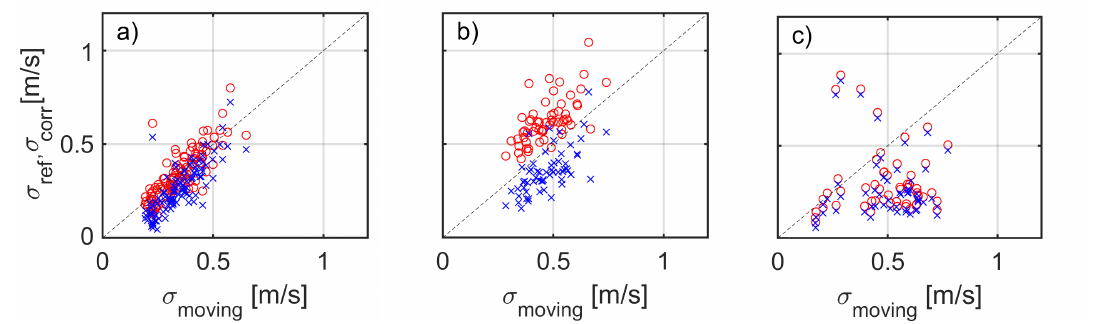
Figure 4. Selected discussion case examples from Table 1. ( a ) case no. 2, HWS = 5 m/s; angular amplitude (AA) = 2 deg; period ( T ) = 4 s; ( b ) case no. 18, HWS = 9 m/s; AA = 3 deg; T = 3